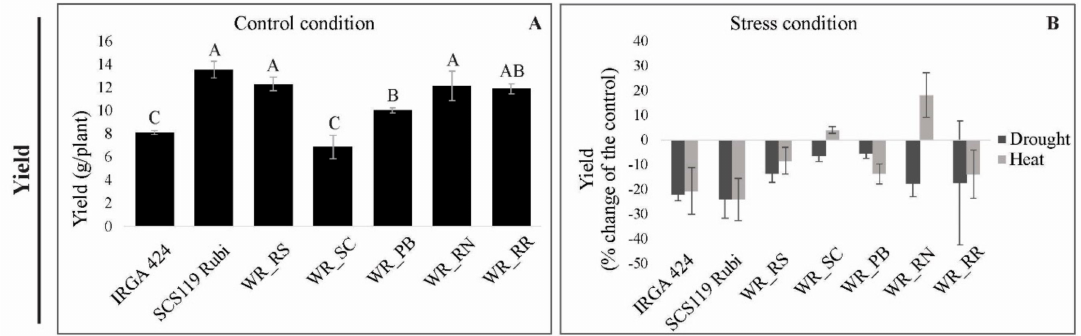
Figure 4. Grain yield of rice and weedy rice genotypes in control ( A ) and stress condition ( B ). Means followed by different uppercase letters are different based on Tukey’s test ( p < 0.05). Vertical bars represent 95% confidence